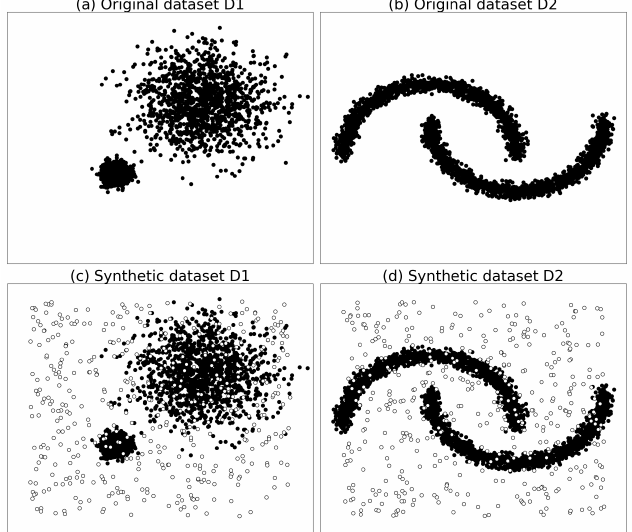
Figure 4. Examples of synthetic datasets analogous to those in Figure 3 but with 3000 points in each dataset.